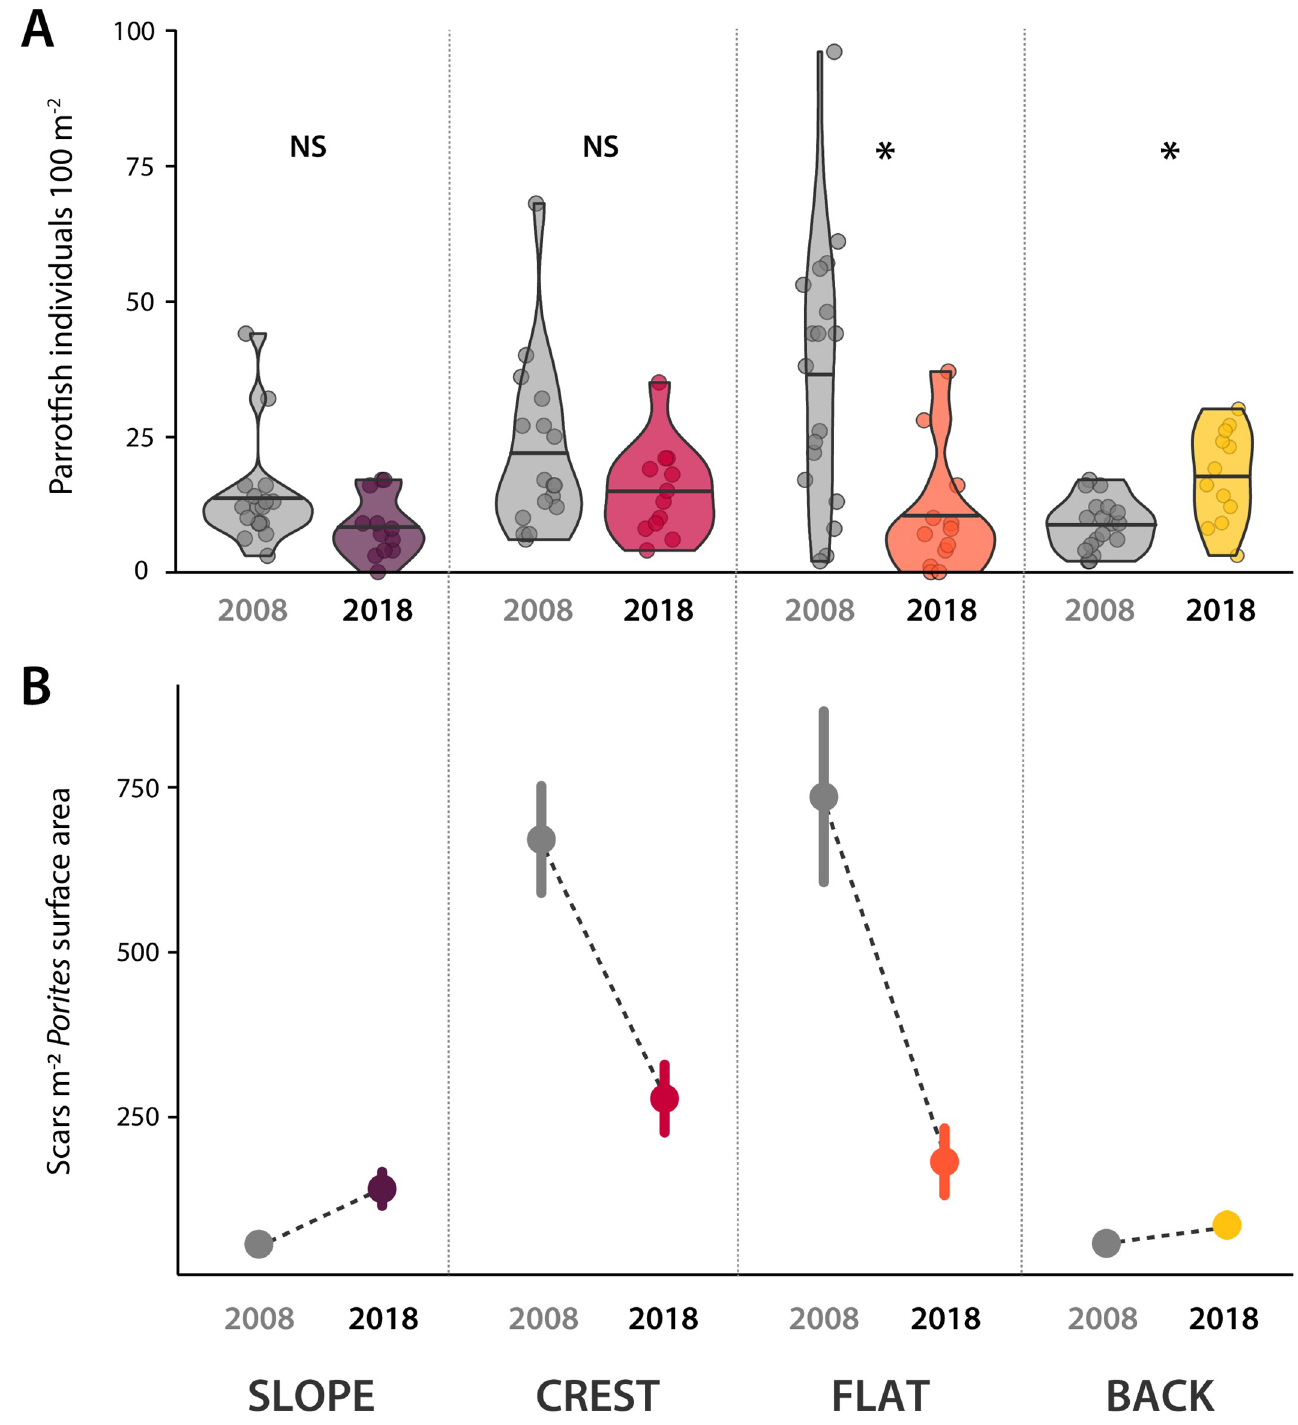
Fig 3. Parrotfish abundance and predation pressure on corals across the study location at Lizard Island, on the Great Barrier Reef. (A) Violin plots representing parrotfish abundance in 2008 (grey) and 2018 (coloured). Horizontal lines indicate the mean. Circles are individual samples. NS: statistically non- significant; � : statistically significant. (B) Predation pressure on massive Porites on the slope, crest, flat and back reef zones at the study site in 2008 (grey) and 2018 (coloured). Circles represent the mean number of scars m -2 and lines indicate the standard error of the mean. Data from 2008 were sourced from [24]. Purple, red, orange, and yellow indicate the slope, crest, flat, and back reef habitats, respectively.